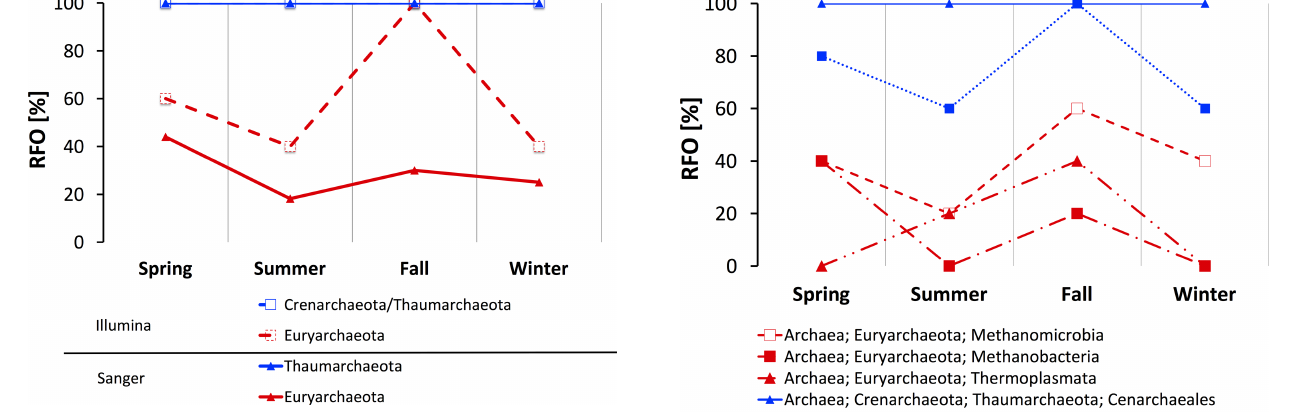
Figure 4. Seasonal variation in the relative frequency of occur- rence (RFO) of airborne archaea on the phylum level. The rela- tive frequency of occurrence – the proportion of samples in which these taxa were detected – is given for both phyla, i.e., Thaumar- chaeota and Euryarchaeota. The graph based on Sanger sequencing represents the data published in Fröhlich-Nowoisky et al. (2014), whereas the remaining data comprises the results of this study.